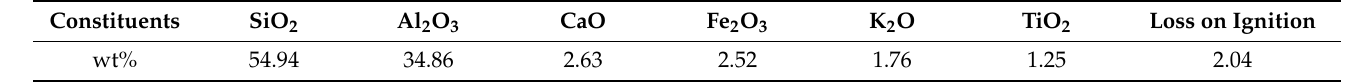
Table 2. The chemical component of fly ash.